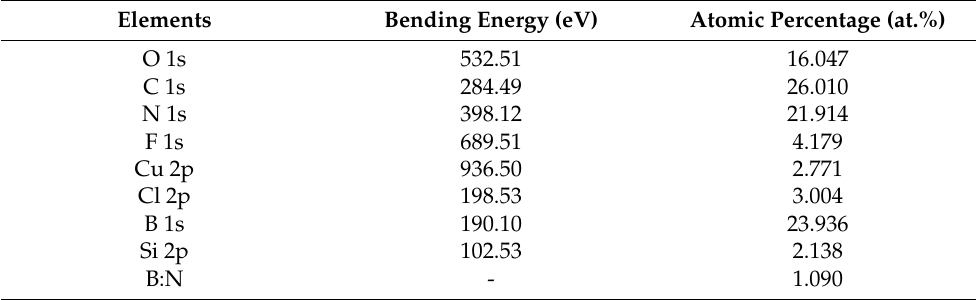
Table 1. Surface composition (at.%) and B:N ratio, as determined by XPS for Cu-BNNT sample. Elements Bending Energy (eV) Atomic Percentage (at.%) O 1s 532.51 16.047